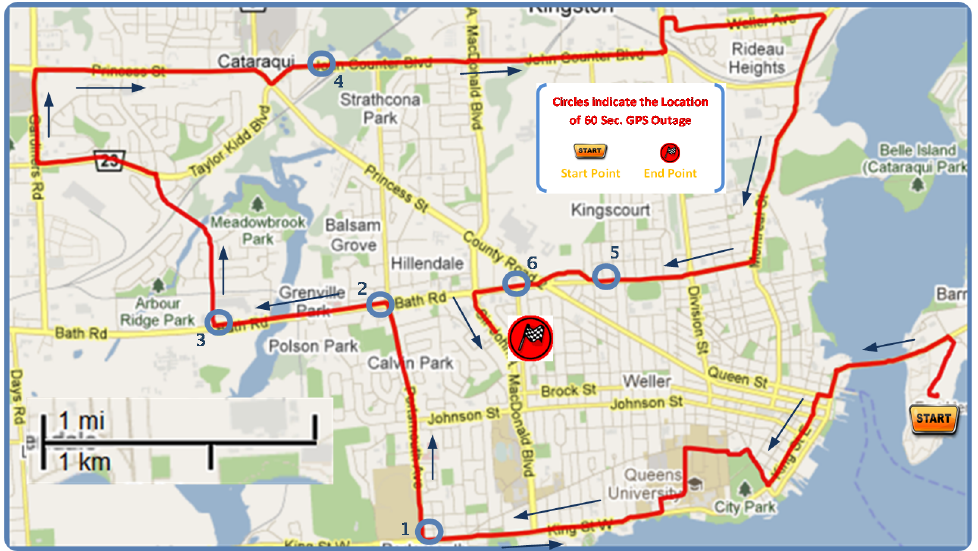
Figure 14. Road test trajectory and circles indicate the approximate locations of 60 s GNSS outages. The trajectory was tested by partial outages having 3, 2, 1, and 0 visible satellites, respectively. The errors estimated by KF-PCI and KF-only solutions for RISS/GNSS integration were evaluated with respect to the NovAtel reference solution. Table 3 shows the average RMS position errors in